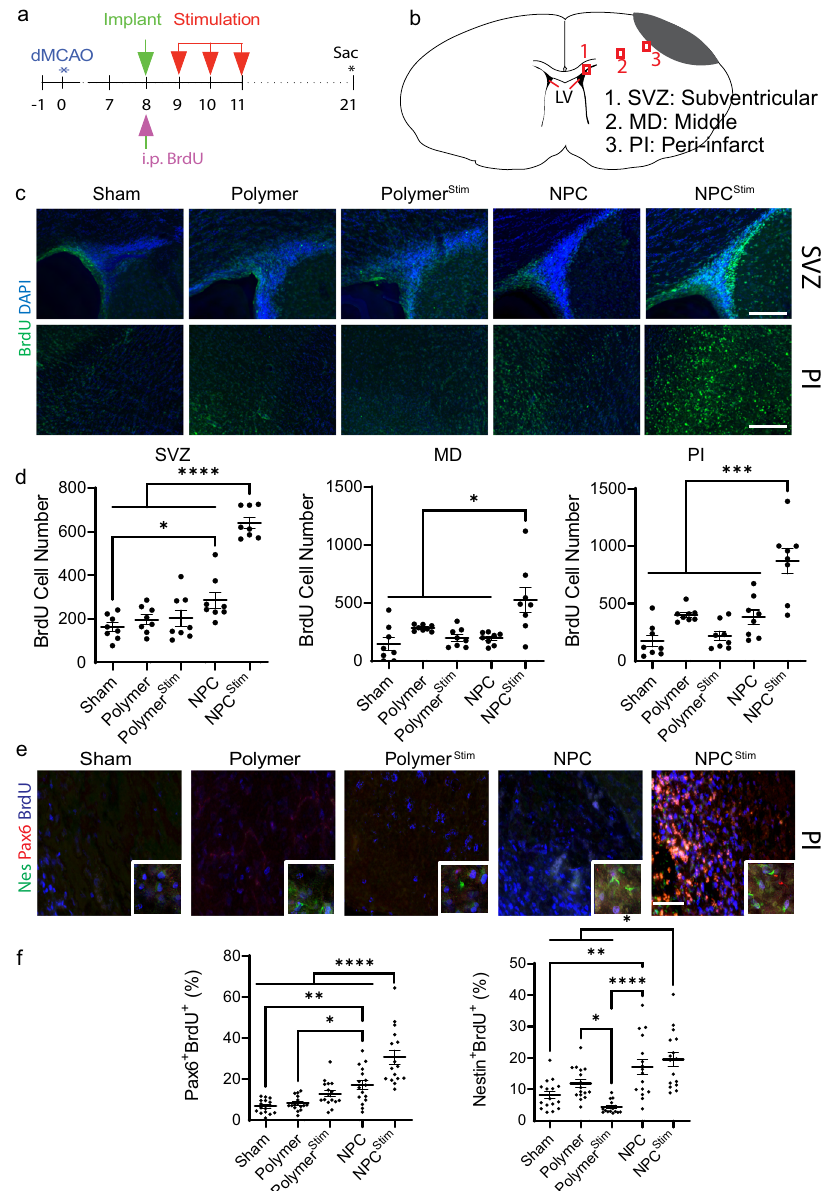
Fig. 2 Combined electrical stimulation and NPCs increase endogenous stem cell production. a Experimental timeline with electrical stimulation three times after implantation surgery. BrdU was administered i.p. when fi rst stimulation was applied. b Schematic of areas of interest in brain tissue. Gray indicates ischemic stroke lesion. Red squares indicate the area of interest: 1. SVZ, 2. MD; and 3. PI (LV – lateral ventricle). c Representative images of fl uorescent-labeled cells. Green indicates BrdU positive cells, whereas blue indicates cell nucleus. Scale bar indicates 200 µ m. d BrdU positive cells in certain area of interest. Data are shown as mean ± SEM, n = 8 images/4 rats. e Representative images of fl uorescently labeled cells. Blue indicates BrdU, green indicates Nestin (Nes), and red indicates Pax6 positive cells. Scale bar indicates 200 µ m. f Co-stained BrdU and Pax6 or Nestin positive cells in peri- infarct area. Data are shown as mean ± SEM, n = 16 images/4 rats. d , f Analyzed using a one-way ANOVA, followed by Tukey ’ s HSD post-hoc test with * P < 0.05, ** P < 0.01, *** P < 0.001, and **** P <